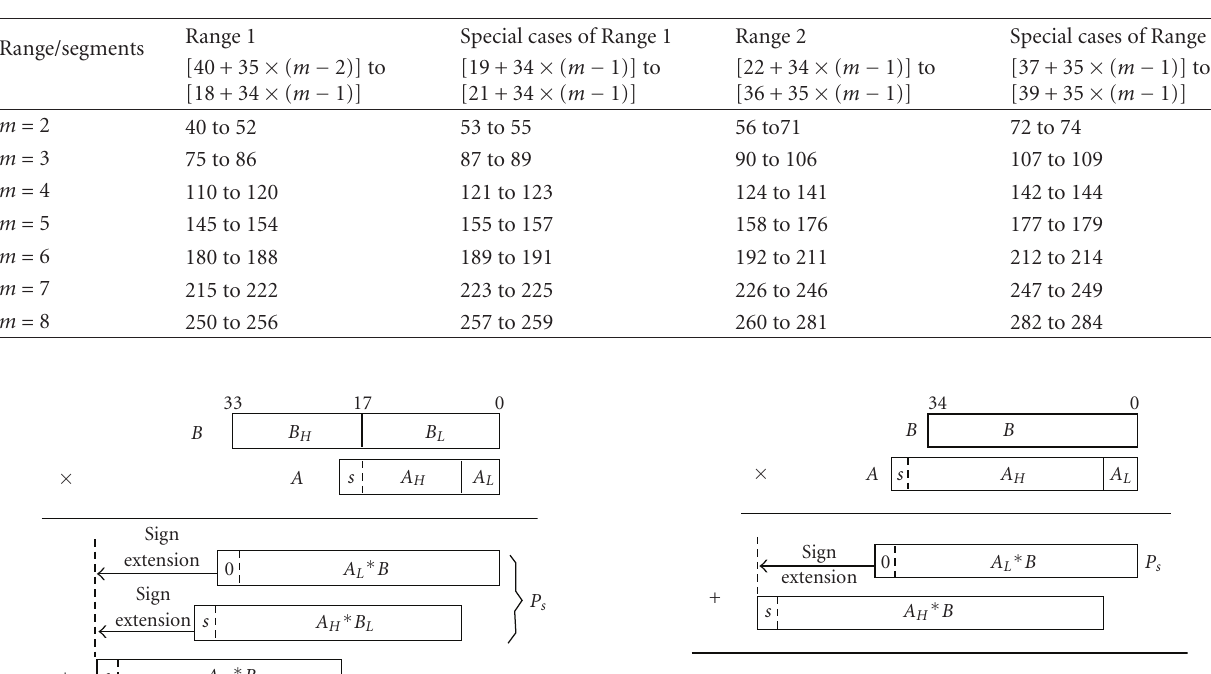
Figure 7: Gereration of the partial product for special cases of Range